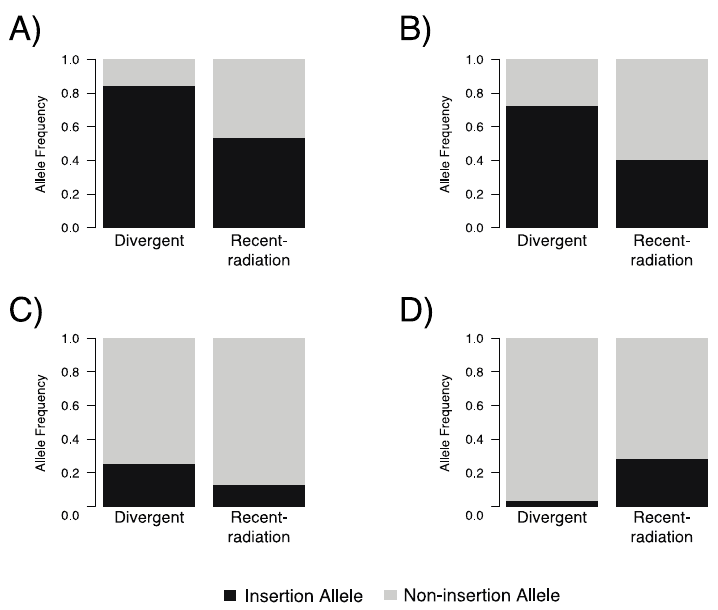
Figure 3. Mean and variation of C-BARQ© scores of behavioral types for assistance ( n = 49) and pet ( n = 69) dogs for ( A ) stranger-directed aggression; ( B ) dog-directed fear; and ( C ) energy. Bar graphs display the frequency of the inserted allele at each locus: ( D ) Cfa6.6; ( E ) Cfa6.7; ( F ) Cfa6.66; and ( G ) Cfa6.83.